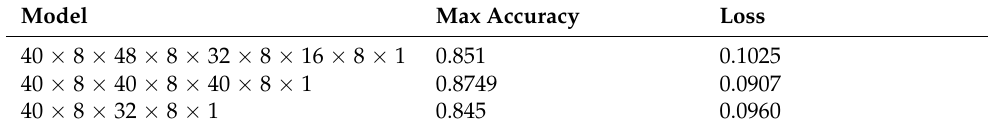
Table 7. Comparison of ANC configurations with the UNSW-NB15 and CIC-IDS2017 datasets. Model